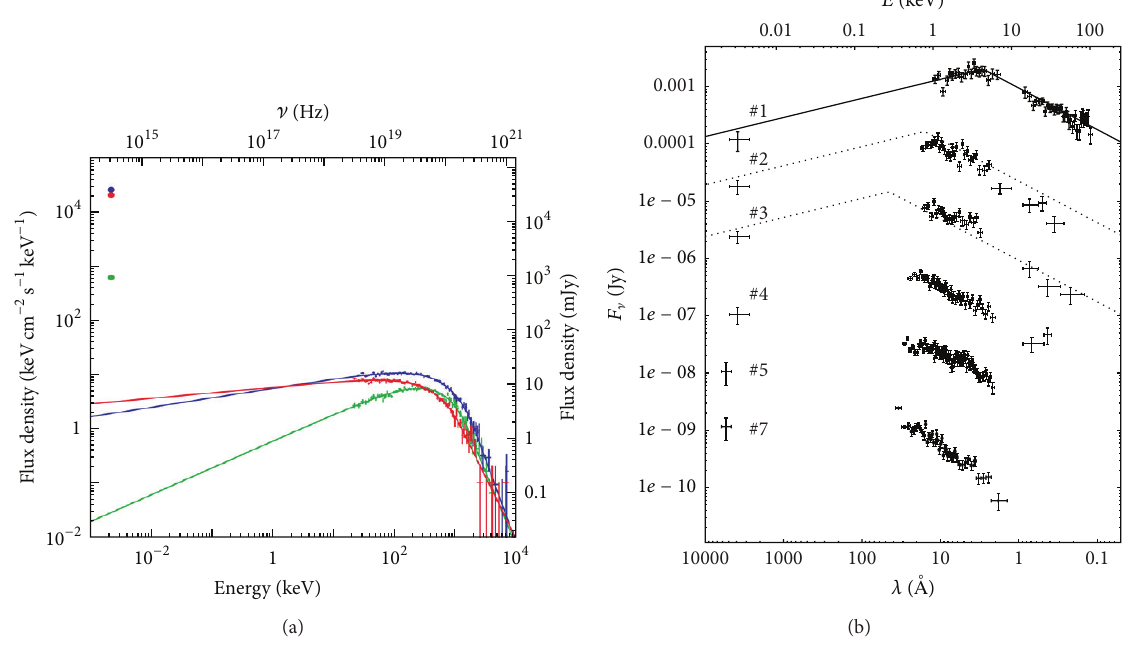
Figure 12: (a) The “Pi in the Sky” and Konus-wind flux at 3 time intervals (fitted by a “Band” model) of GRB080319B. The optical flux is 2-3 orders of magnitude above the direct interpolation. Figure taken from Racusin et al. [116]. (b) Combined UVOT and X/ 𝛾 ray data of GRB080928 at early times are fitted with a broken power law. For this burst, the slope is consistent with having synchrotron origin. Figure taken from Rossi et al.